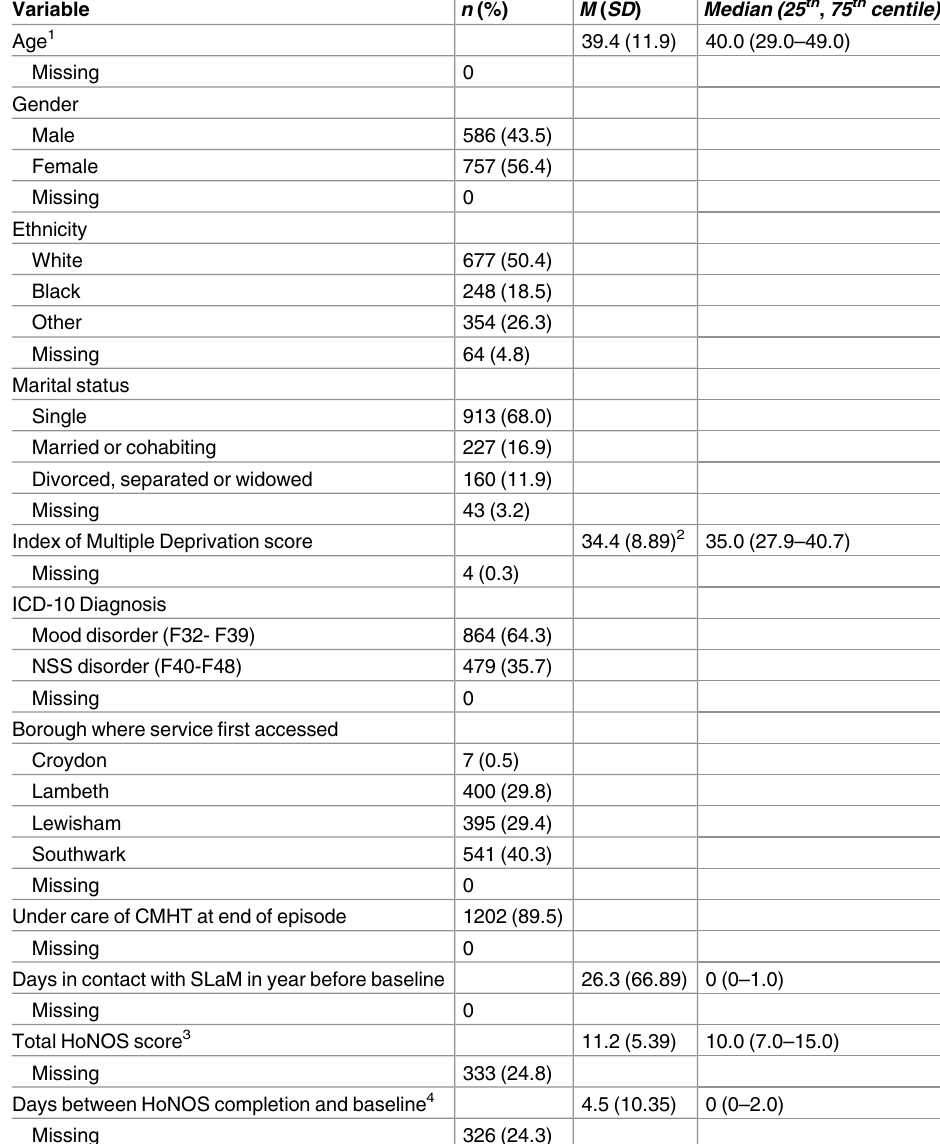
Table 1. Sample characteristics ( N =